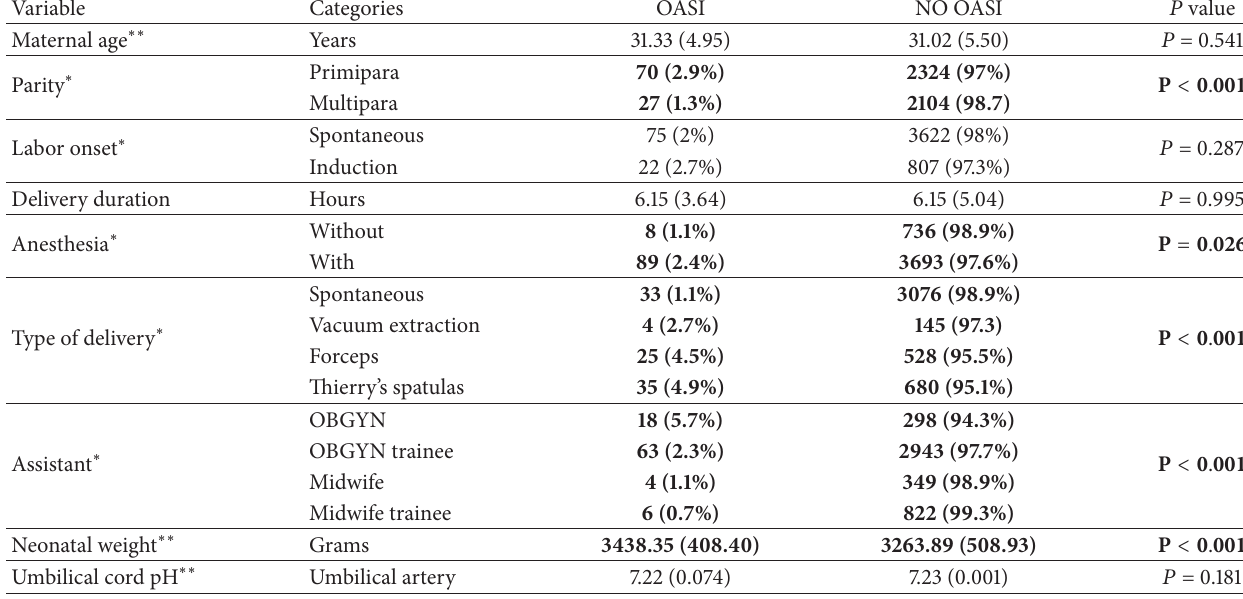
Table 3: Summary of bivariate analysis results.